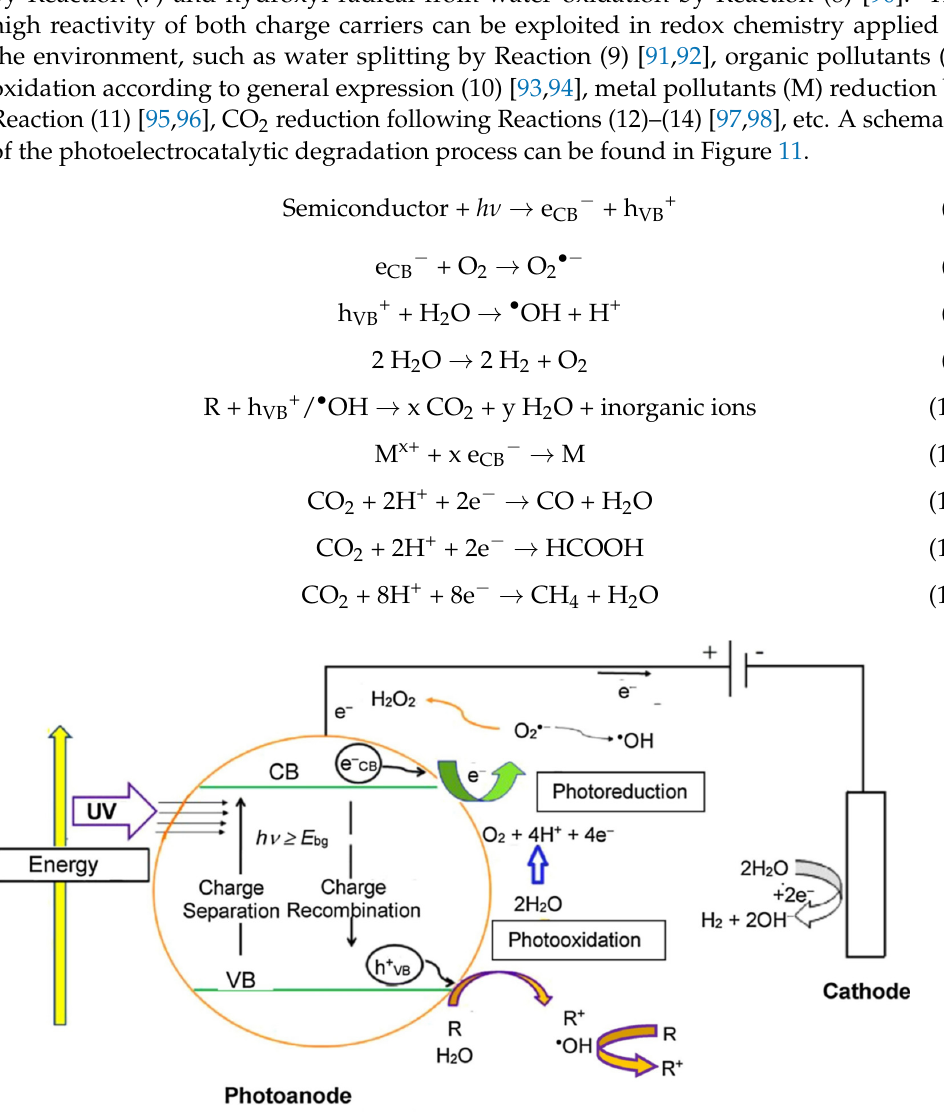
Figure 11. Schematic of the PEC process